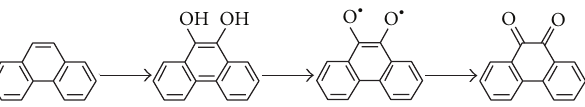
Figure 10: The possible way of reaction of potassium ferrate with